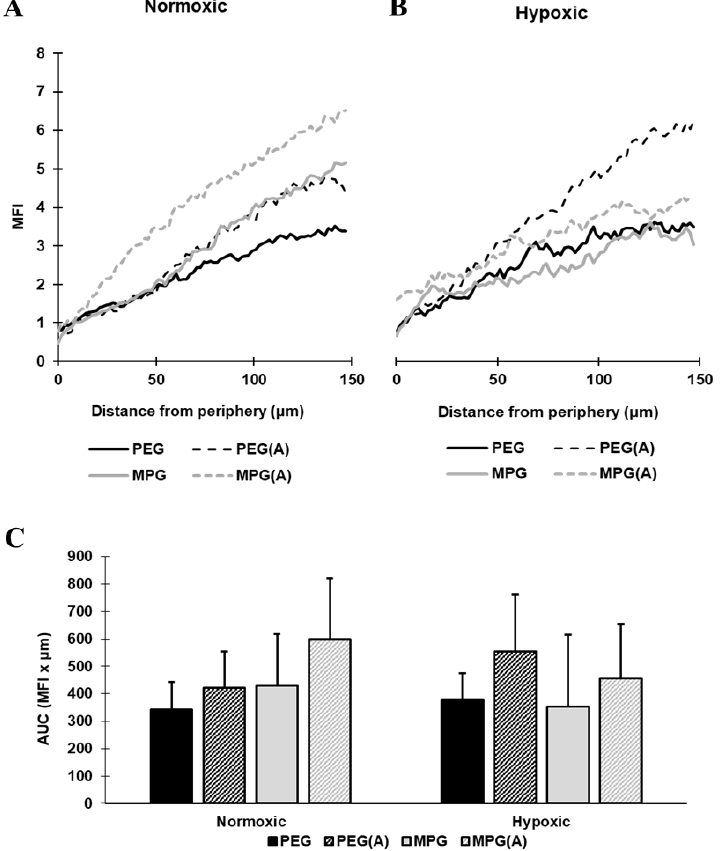
Figure 7. No statistical significance was observed between PEG and MPG NP penetration into PMX spheroid composed of activated SKOV-3/MRC-5 cells cultured in normoxic or hypoxic conditions. ( A , B ) Quantification of surface-modified PLGA NP transport into the tumor center as a function of MFI in normoxic and hypoxic conditions. ( C ) Quantification of area under the MFI curves. No statistical significance was observed as a function of activation, hypoxia, or NP type. Error bars represent the mean ± standard deviation.